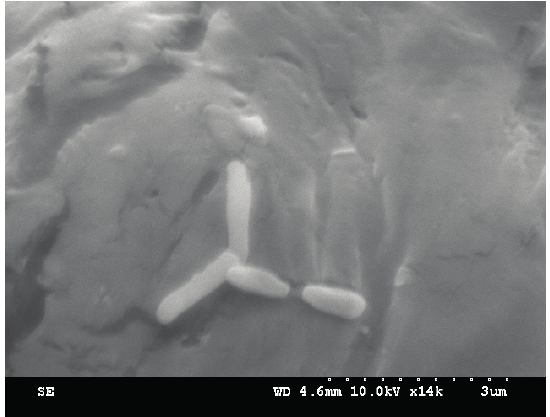
Figure 1. Scanning electron micrograph of strain